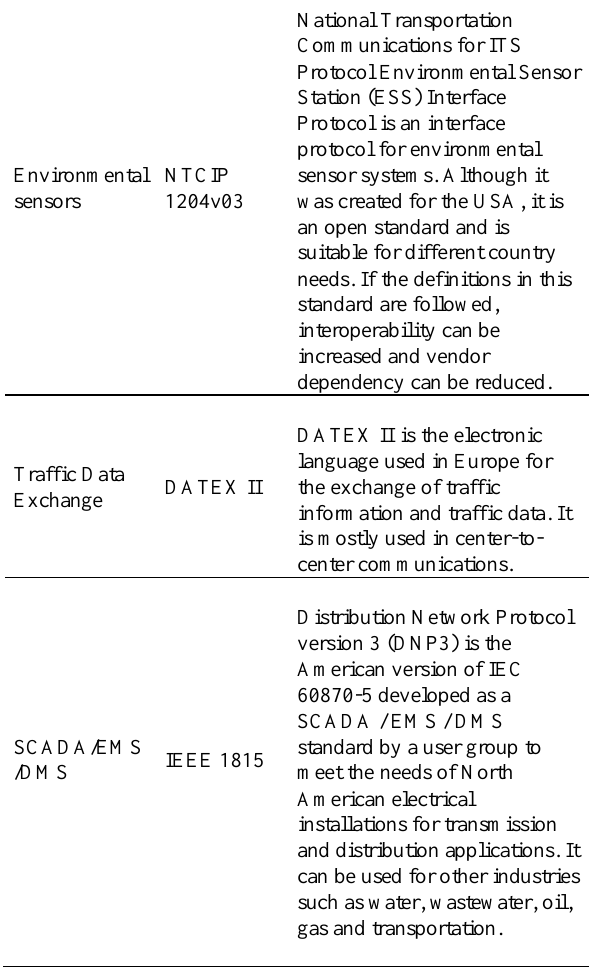
Table 2. Recommended Standards for Specific Smart City